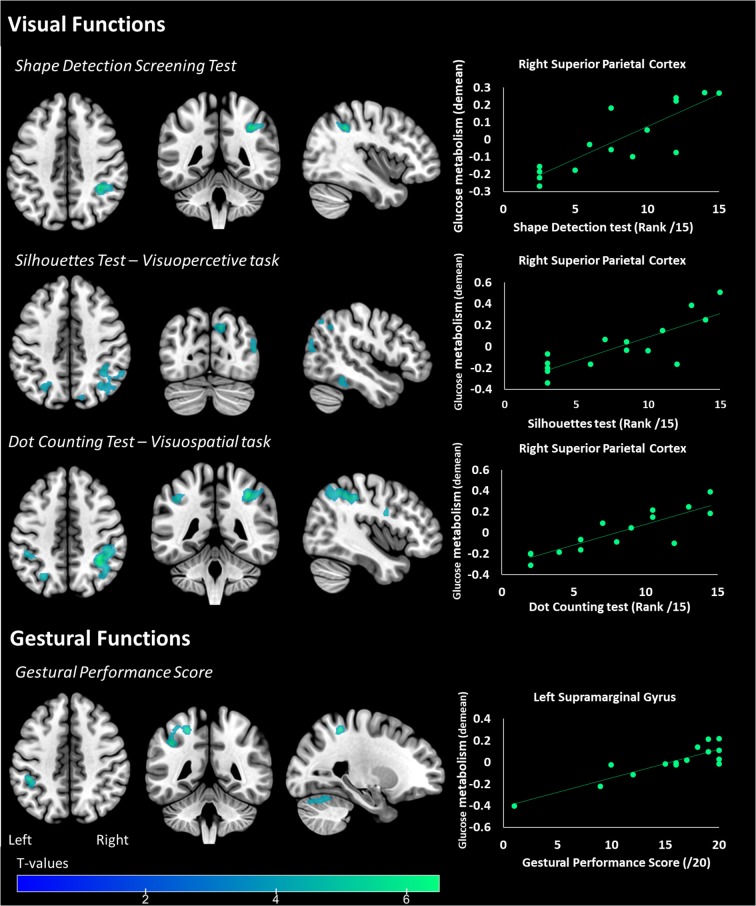
Areas of the brain where metabolism correlates with primary visual functions (Shape detection Screening Test), visuoperceptive (Silhouettes Test), visuospatial (Dot Counting Test), and gestural functions in PCA patients. The statistical threshold is puncorr < 0.001 (k > 50 voxels). Correlations on the right panel are performed on the whole cluster considered (i.e., the right superior parietal cortex for visual functions and the left supramarginal gyrus for gestural functions).